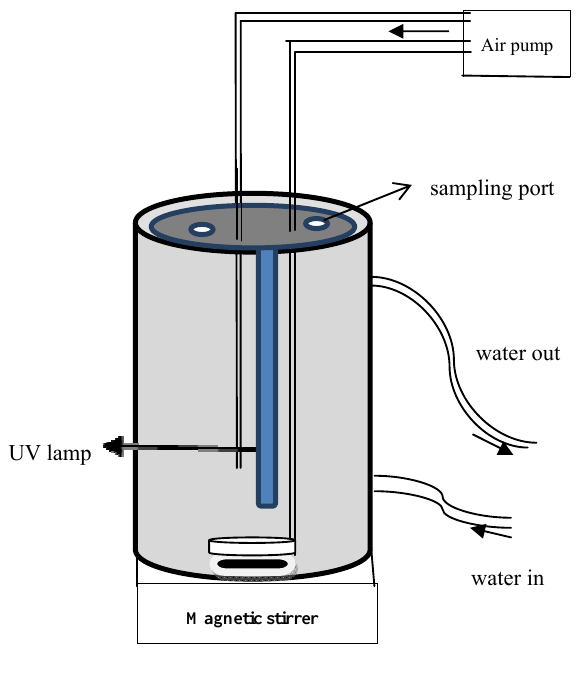
Figure 1. Schematic diagram of batch UV